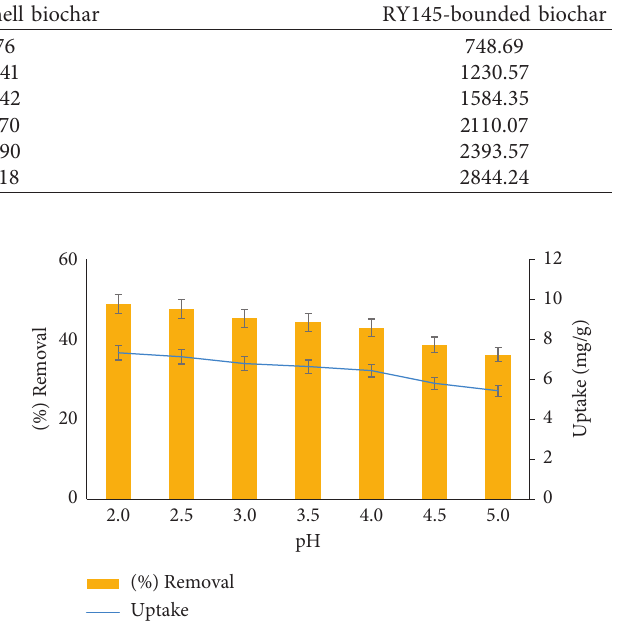
Figure 4: Effect of equilibrium pH on RY145 removal and